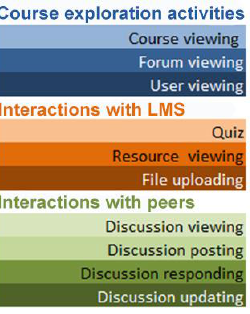
Figure 5. Legend of color themes.